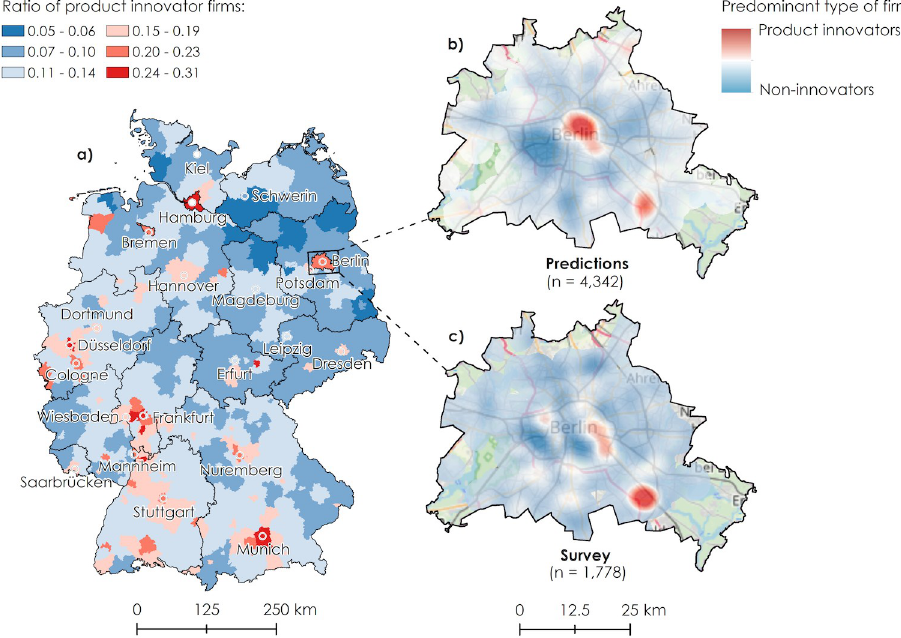
Fig 3. Geographic pattern of product innovator firm predictions. Predicted share of product innovator firms in local firm population by German districts (a). Microgeographic pattern of product innovator firms in Berlin, predicted (b) and surveyed (c). Basemap: